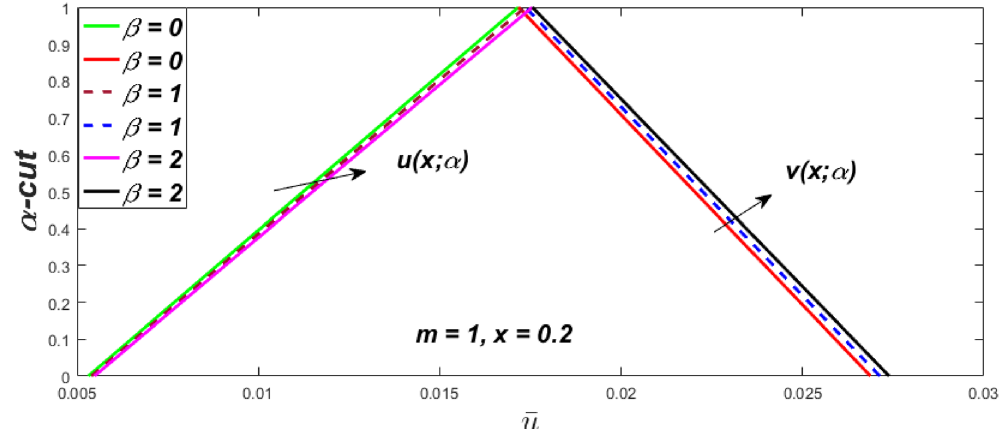
Figure 13. Triangular MF of fuzzy velocity profiles for impact of β .